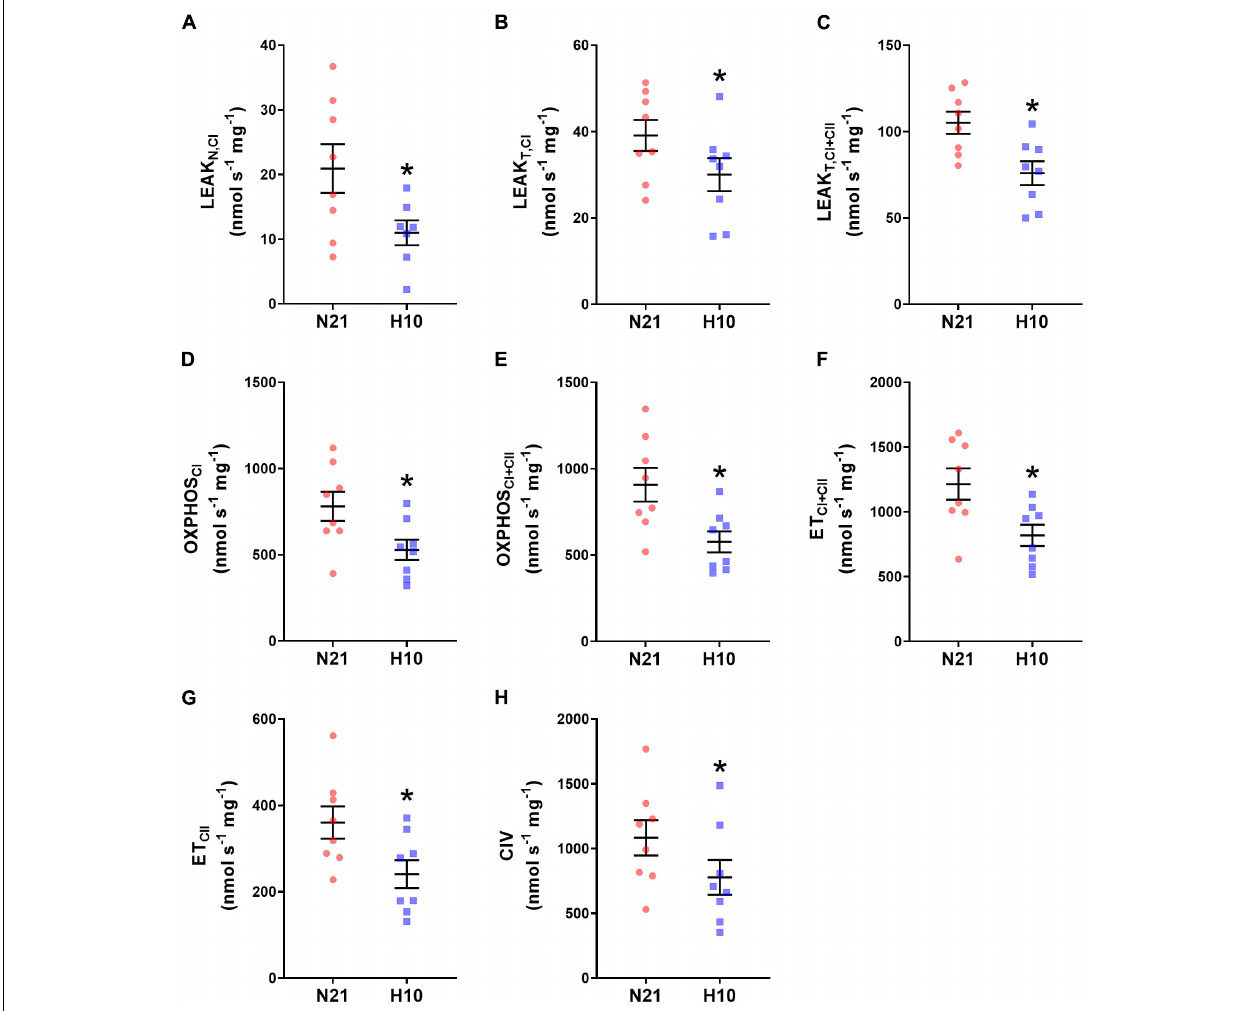
FIGURE 2 | Effect of developmental hypoxia on mitochondrial O 2 consumption. Mitochondrial O 2 consumption was measured in juvenile snapping turtles from normoxic (N21, red circles, n = 8) and hypoxic (H10, blue squares, n = 8) incubations. Each panel represents a respiratory state. (A) Leak respiration with substrates for complex I, in the absence of adenylates (Leak N , CI ). (B) Leak respiration with substrates for complex I, in the presence of adenylates (Leak T , CI ). (C) Leak respiration with substrates for complexes I and II, in the presence of adenylates (Leak T , CI + CII ). (D) Oxidative phosphorylation, with substrates for complex I (OXPHOS CI ). (E) Oxidative phosphorylation with substrates for complexes I and II (OXPHOS CI + CII ). (F) Electron-transfer capacity, with substrates for complexes I and II (ET CI + CII ). (G) Electron-transfer capacity, with substrates for complex II (ET CII ). (H) Electron donation to complex IV (CIV). Statistical significance was assessed with individual generalized linear models, followed by Sidak post hoc tests, to assess the effect of developmental O 2 (N21 vs. H10). Values were considered significant when P ≤ 0.05, which are denoted by asterisks